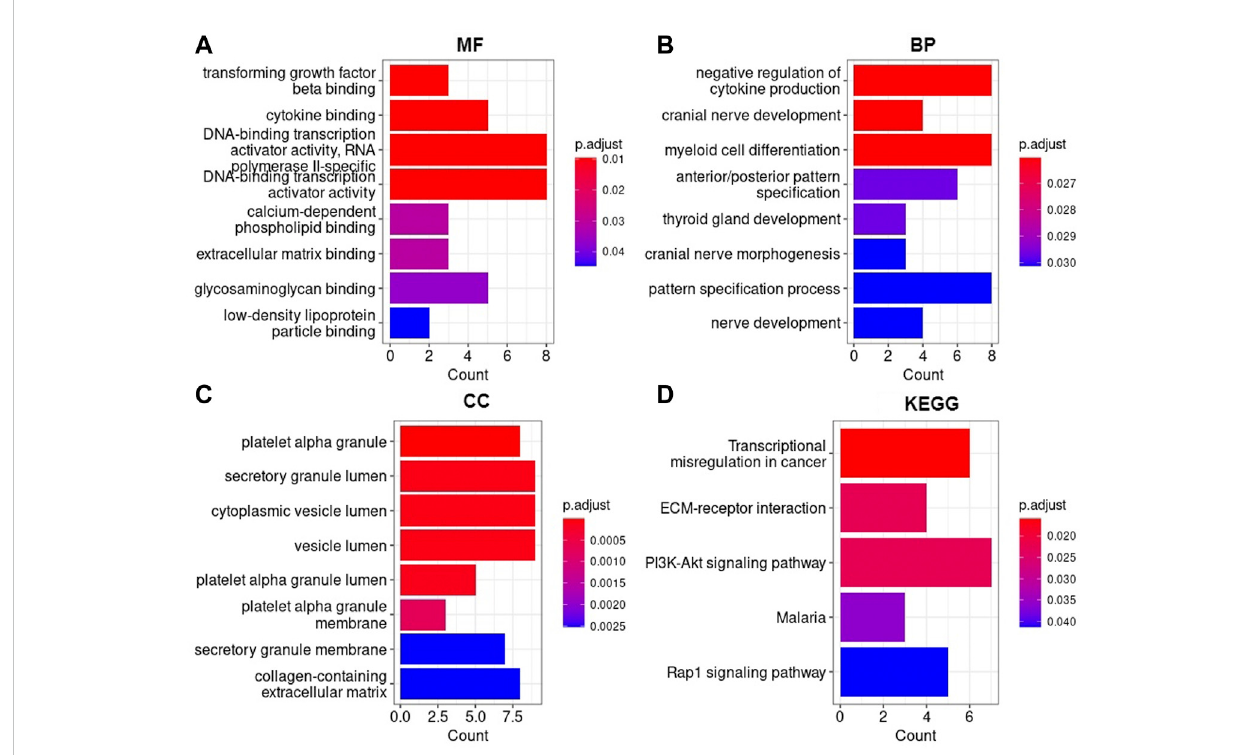
FIGURE 7 AML DEGs were enriched in Gene Ontology and KEGG pathways (A) Molecular function, (B) Biological process, (C) Cellular component, (D) Kyoto Encyclopedia of Genes and Genomes. The horizontal axis represents the number of enriched genes, and the vertical axis represents the gene ontology project and KEGG pathways,